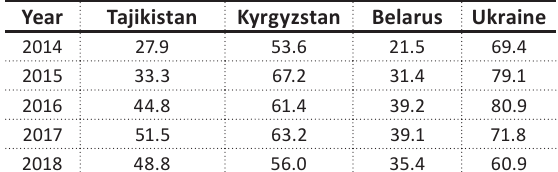
Table 2. Share of government debt in GDP, %